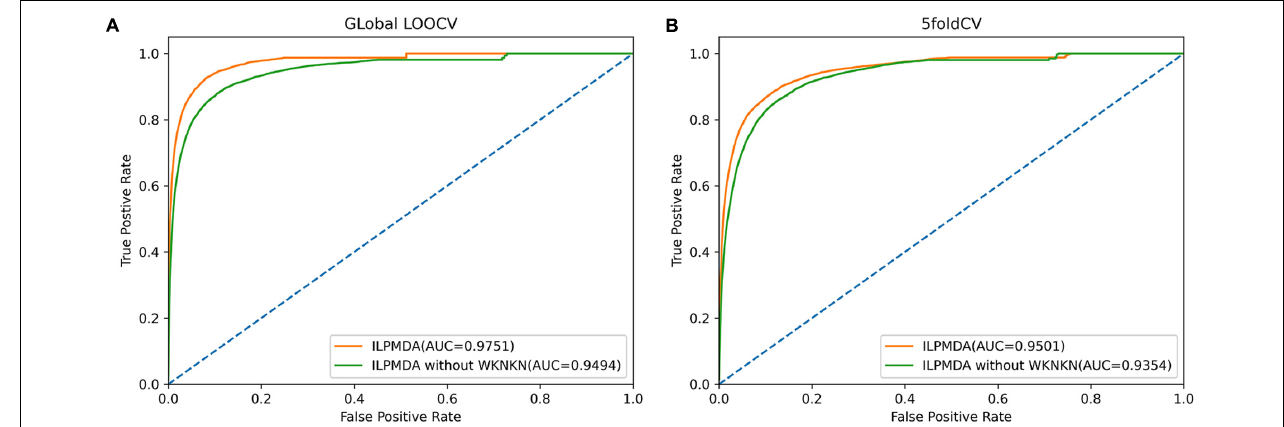
FIGURE 6 | The ROC curves of ILPMDA and ILPMDA without WKNKN: (A) global LOOCV (B) 5-CV.